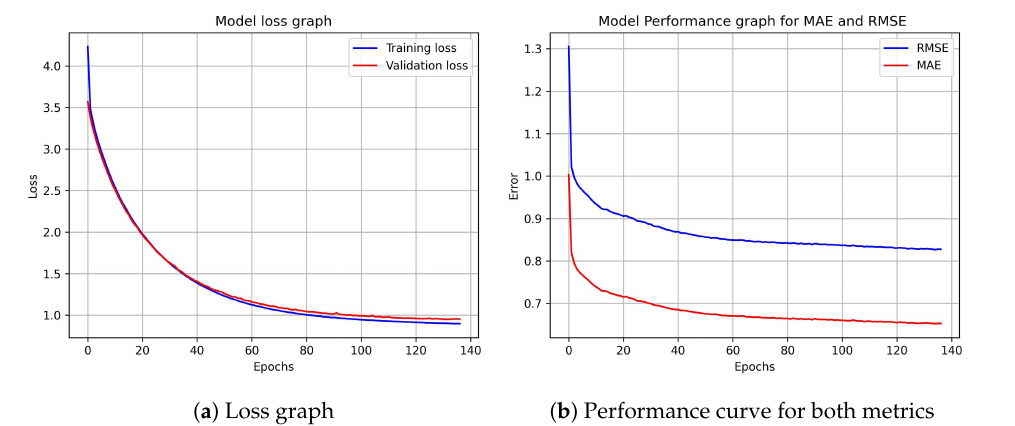
Figure 2. A model with 2 hidden-layer for the ML-100K dataset. In Part ( a ), we have the training and validation loss curve versus the number of training epochs, and in Part ( b ), we have the performance results. As observed, the method converges.